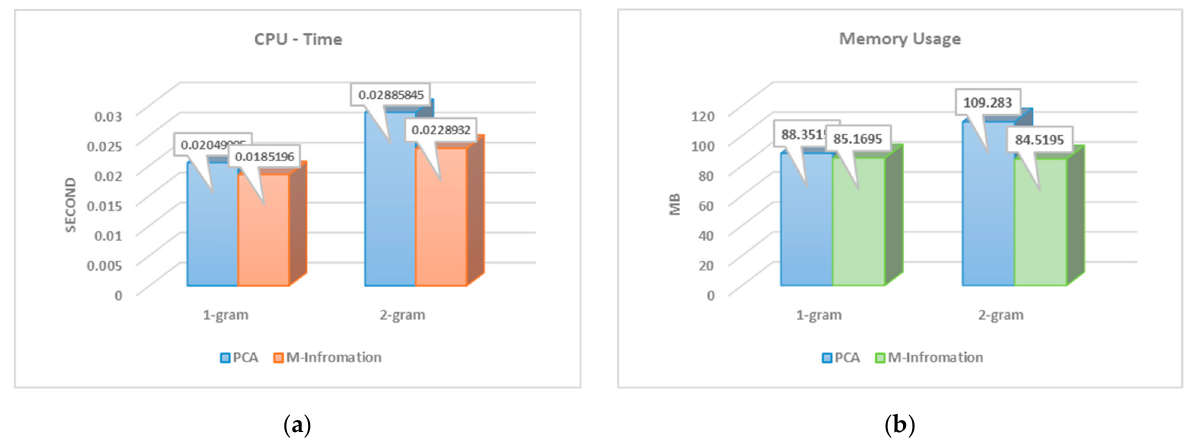
Figure 7. Feature selection comparison between PCA and MI using 1-gram and 2-gram: ( a ) CPU time performance; ( b ) memory usage performance.